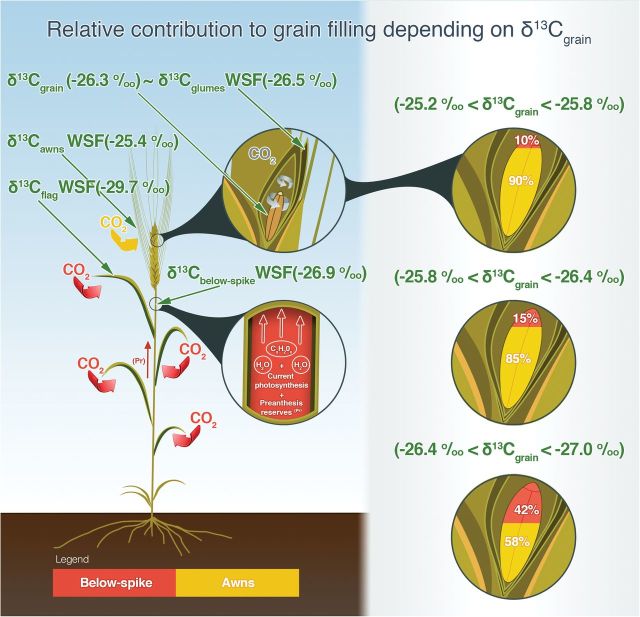
Illustration of a wheat plant showing the relative photosynthetic contributions of the ear and shoot to grain filling. The below-spike integrates the δ13C of the assimilates produced by the different photosynthetic organs of the shoot plus the stem reserves. The δ13Cawns, δ13Cglumes, and δ13Cbelow-spike represent the carbon isotopic composition of the WSF in the awns, glumes, and below-spike, respectively. δ13Cgrain represents the carbon isotopic composition of mature kernels. (This figure is available in colour at JXB online.)